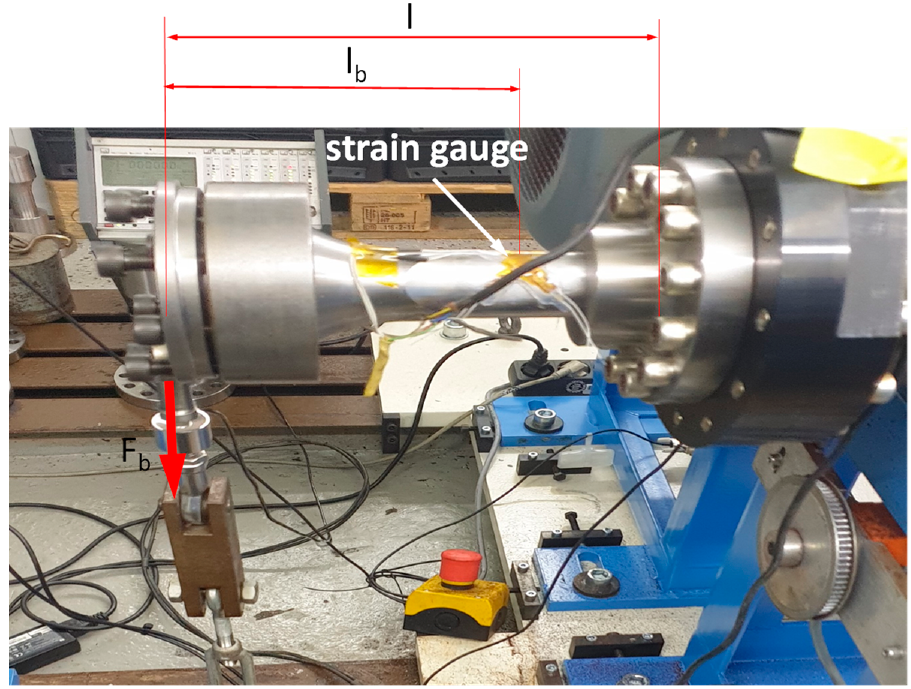
Figure 8. Bending loads test bench (Machine Elements Laboratory at West Saxon University of Zwickau). Experimental results for head and foot areas are compared with Equations (15) and (16) in Figure 9, where a good agreement of the results is